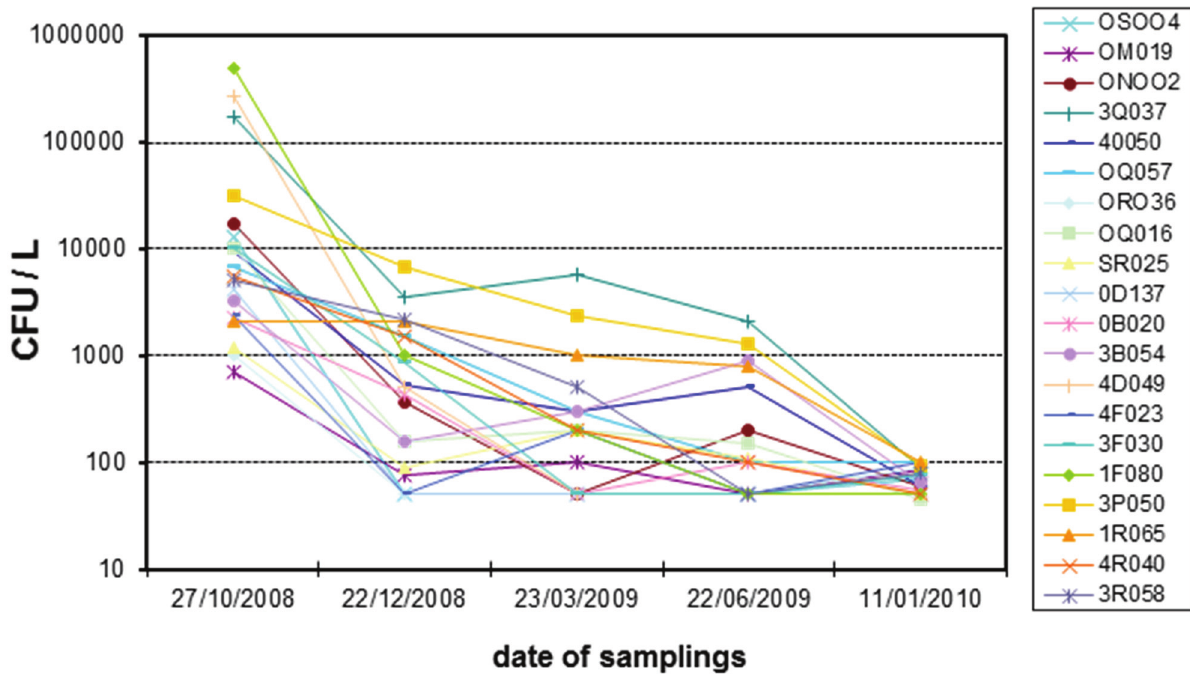
Figure 2. Trend of Legionella colony counts, as a function of time, in the first months of operation of the anolyte-based disinfection system (method 1). Cardinal Massaia Hospital, Asti. From 2010 onwards, the contamination remained constantly below 100